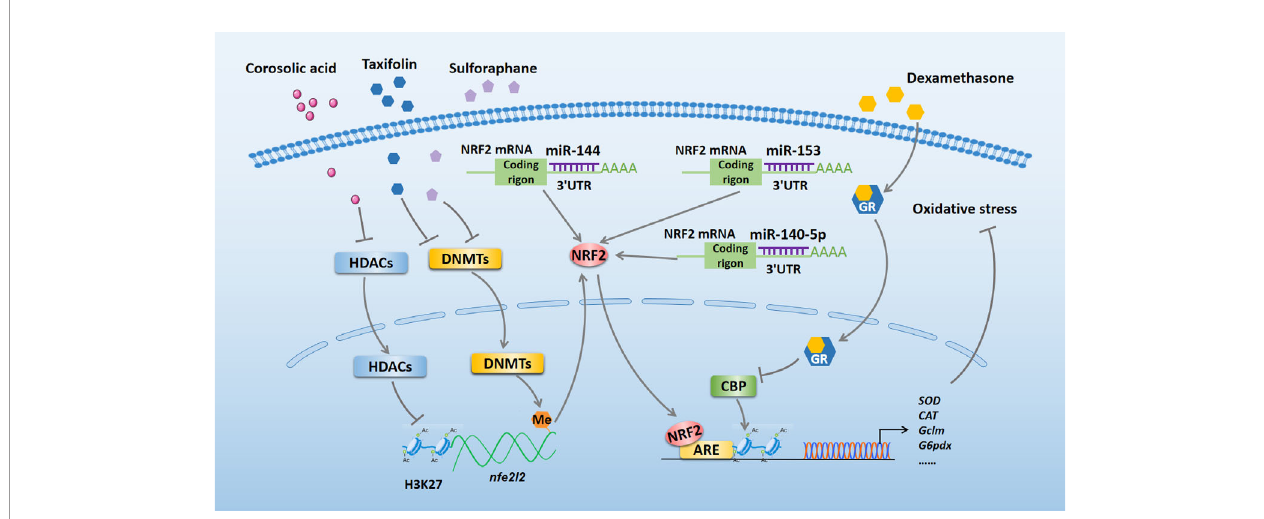
FIGURE 1 | NRF2-related epigenetic mechanisms in the regulation of oxidative stress. Taxifolin and sulforaphane reduce DNA methylation of the Nfe2l2 promoter region to exert antioxidant effect by inhibiting the expression of DNMTs. Corosolic acid increases acetylation of H3K27 in the Nfe2l2 promoter region to exert antioxidant effect by inhibiting the expression of HDACs. Dexamethasone enhances GR recruitment to AREs to block NRF2-dependent CBP recruitment and histone acetylation at AREs, which inhibits the transcriptional activation of NRF2 target genes and reduces its antioxidant function. miR-140-5p, miR-153, and miR-144 bind to the 3 ’ UTR of NRF2 to aggravate oxidative stress by inhibiting NRF2 expression. NRF2, nuclear factor erythroid 2-related factor 2; miR, microRNA; DNMTs, DNA methyltransferases; HDACs, histone deacetylases; GR, glucocorticoid receptor; CBP, CREB-binding protein; ARE, antioxidant response element; SOD, superoxide dismutase; CAT, catalase; Gclm, glutamate-cysteine ligase modi fi er; G6pdx, glucose-6-phosphate dehydrogenase X-linked; 3 ’ UTR, 3 ’ untranslated